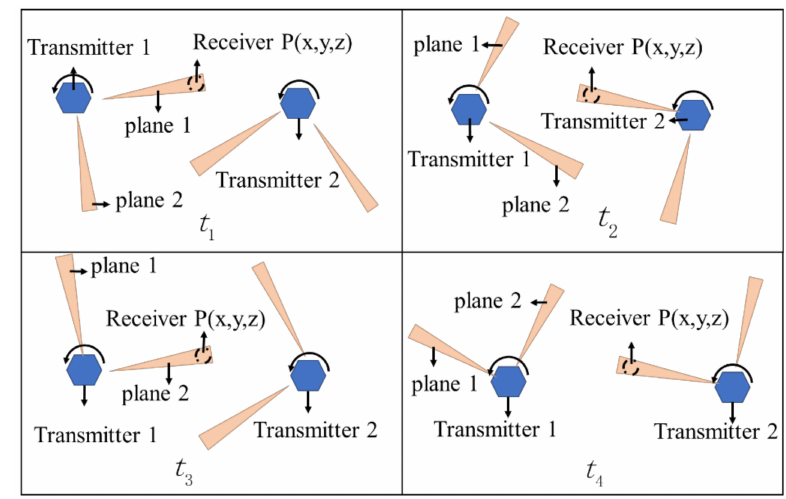
Figure 11. Effect of out-of-sync rotation of transmitting stations on the intersection relationship during static state of the receiver. From left to right: the moment when the plane 1 of the transmitter 1 scans over the receiver; the moment when the plane 1 of the transmitter 2 scans over the receiver; the moment when the plane 2 of the transmitter 1 scans over the receiver; the moment when the plane 2 of the transmitter 2 scans over the receiver. It is obvious that the receiver in the same position when the planes scans over the receiver separately, the information delay caused by different rotation speed of the transmitting stations will not influence the static measurement of the wMPS.